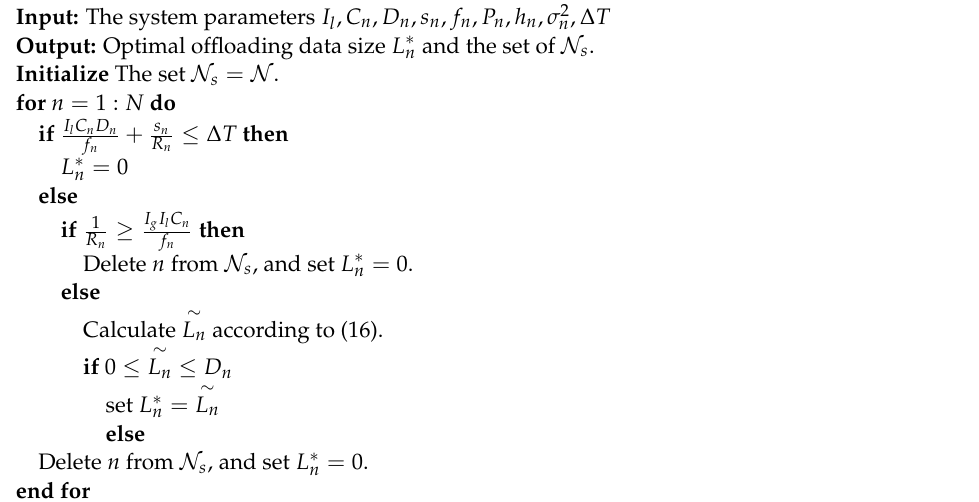
Algorithm 1: Edge-Assisted Offloading Strategy with Perfect